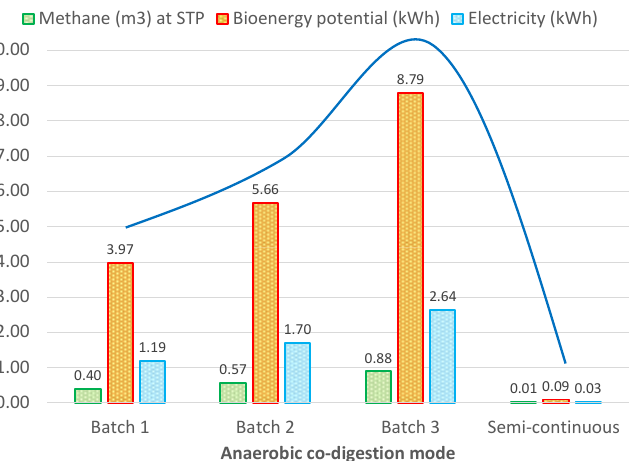
Figure 7. Bioenergy potential derived from anaerobic digestion ISCW with cattle manure (batch and semi-continuous modes).